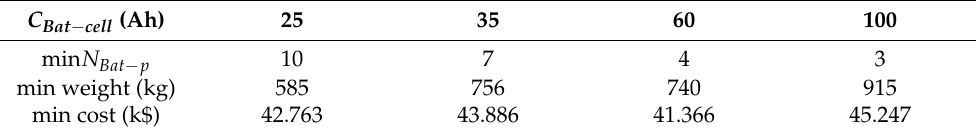
Table 6. Batteries of different capacities matching